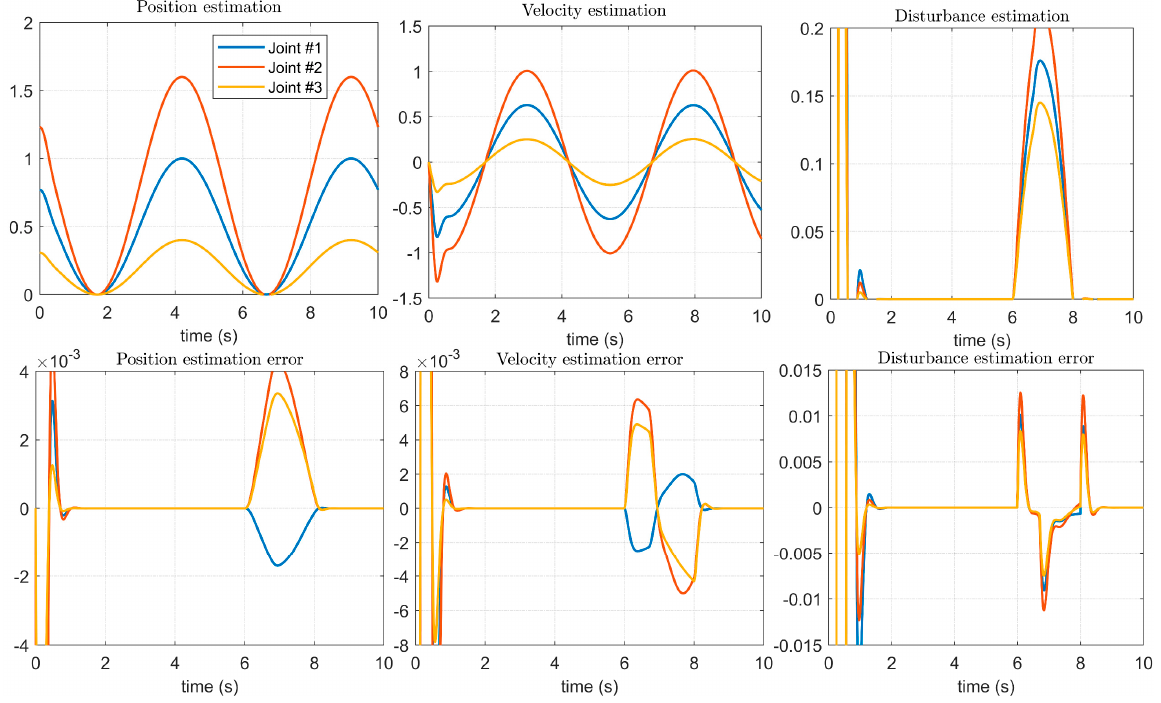
Figure 10. Estimation of control signals and disturbances using the method in [14].